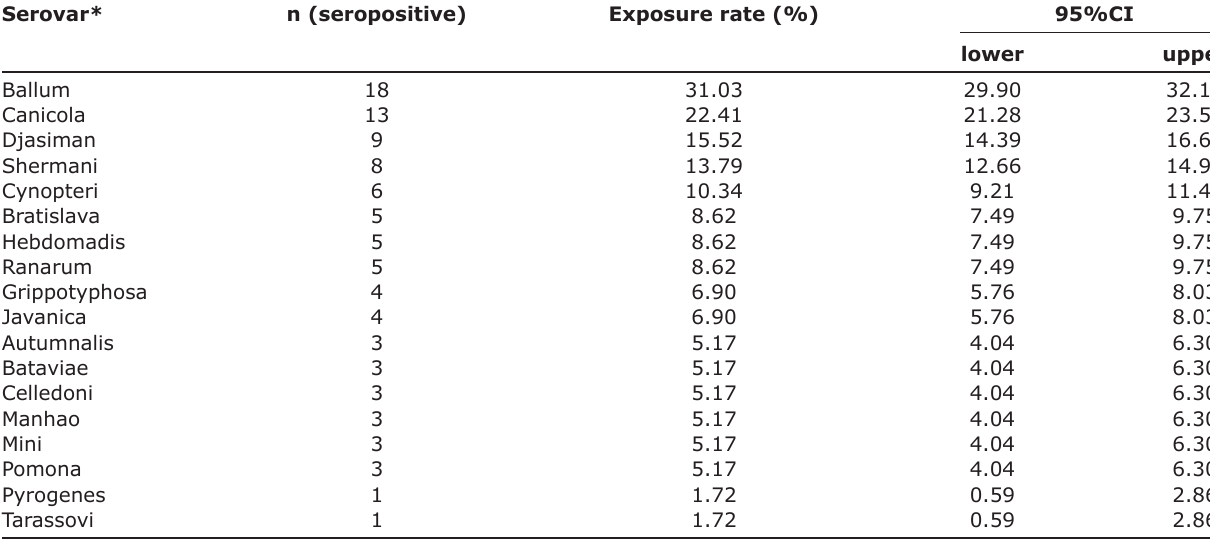
Table-1: The overall seropositive by using microscopic agglutination test (MAT) in 36 out of 58 wild boars from Khao Prathab Chang Wildlife Breeding Center, Thailand. Serovar* n (seropositive)